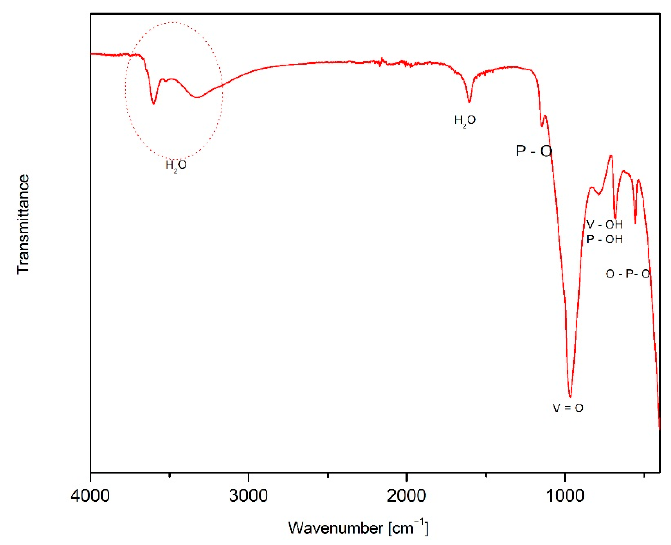
Figure 3. FTIR spectrum of the VOPO 4 ∙ 2H 2 O.